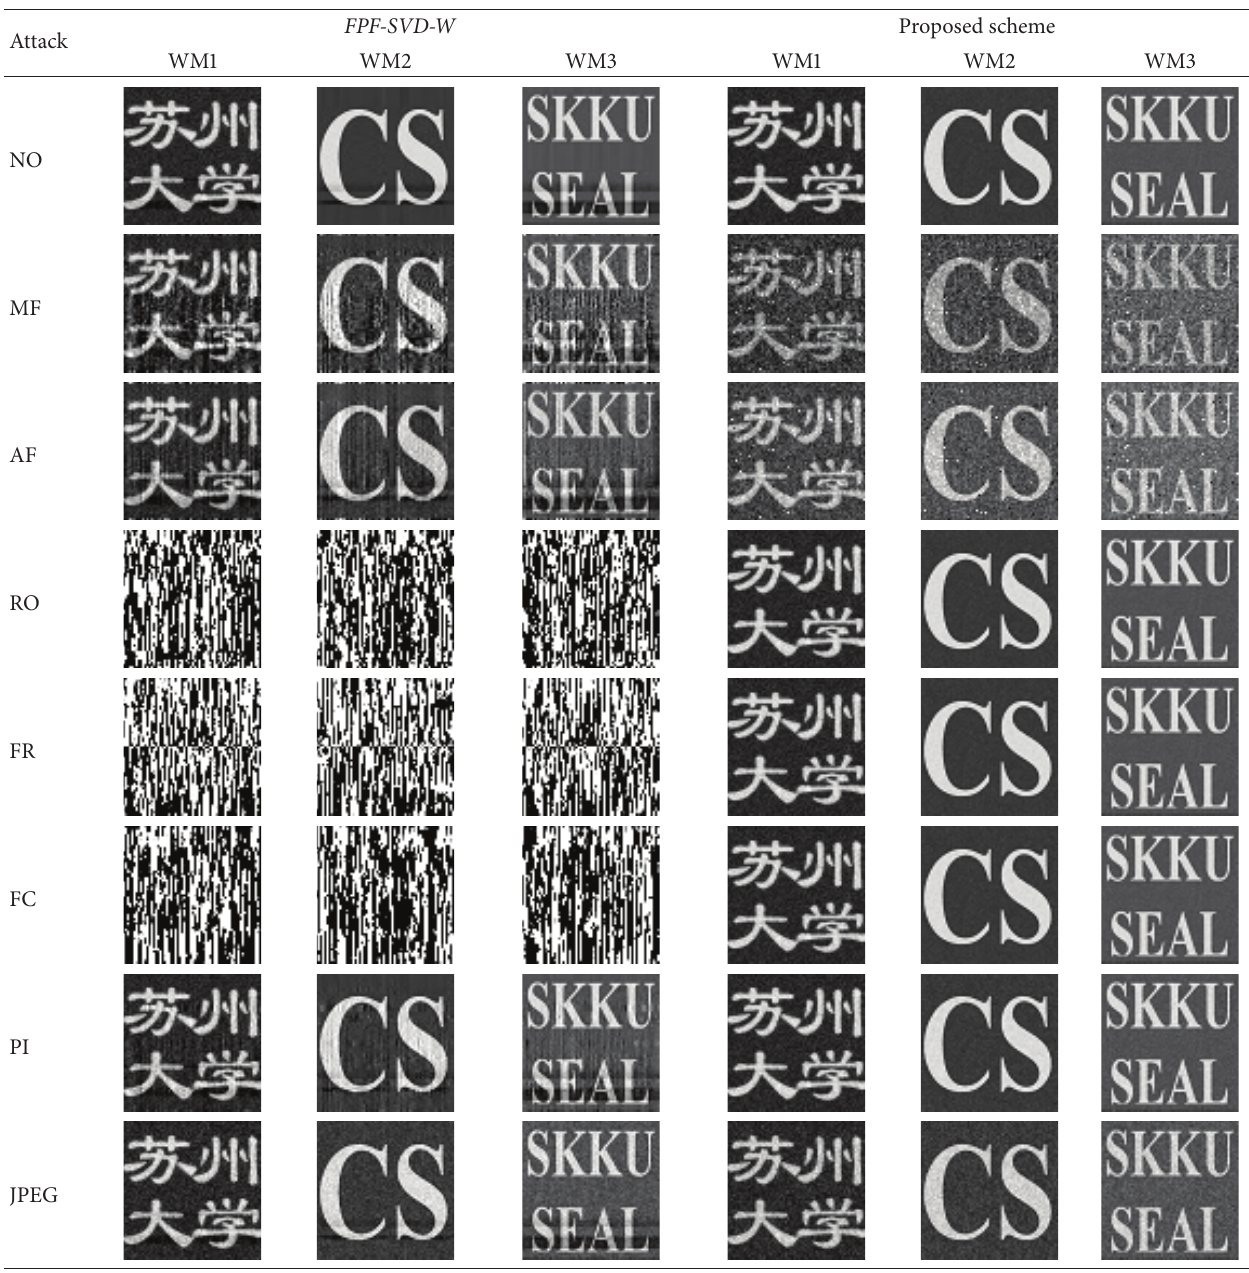
Table 6: Extracted watermarks from the watermarked images that are distorted by various